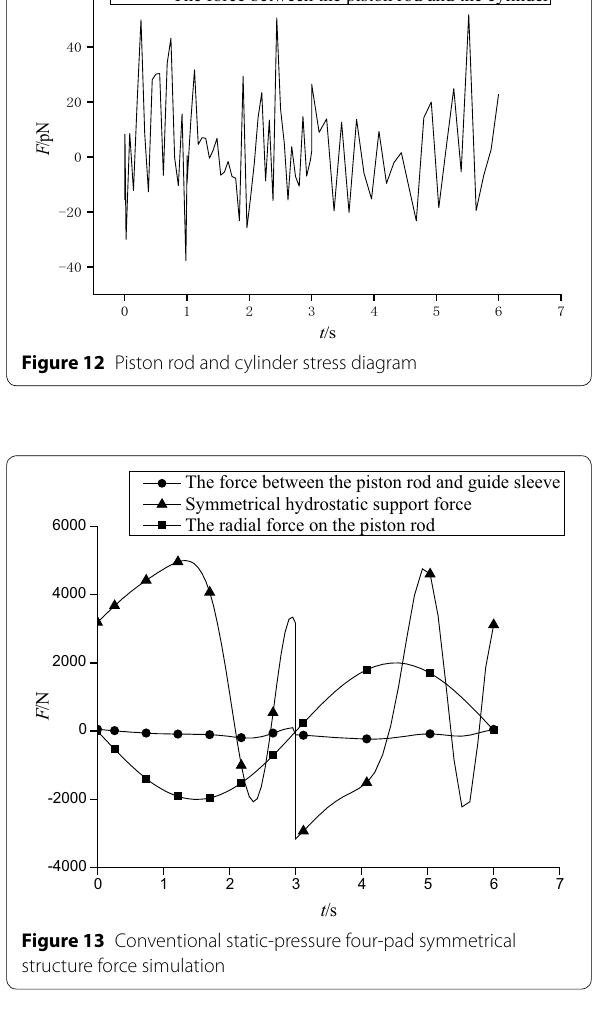
force between the piston rod and the cylinder